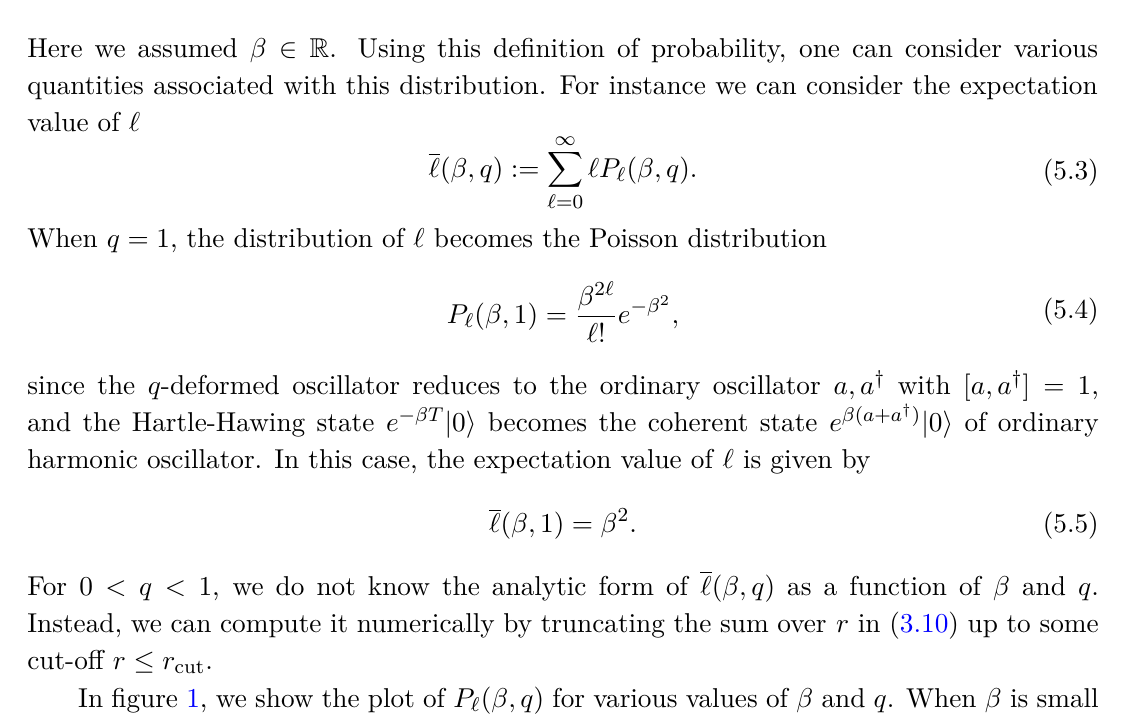
Figure 1. Plot of P ‘ ( β, q ) against ‘ for various values of β and q